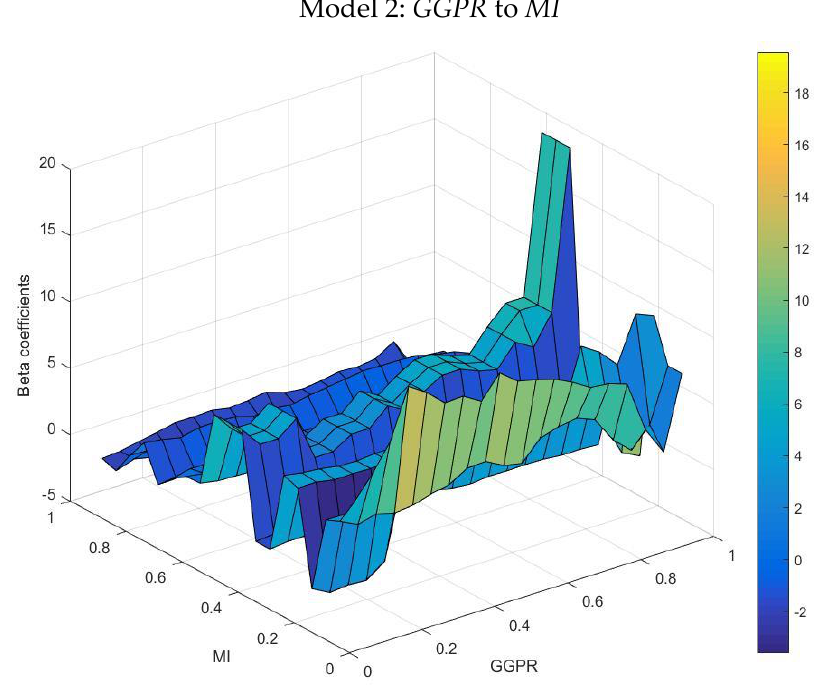
Figure 7. Global geopolitical risk ( GGPR ) and mineral import ( MI ). Notes: The z -axis exhibits the slope coefficients against the quantiles of MI ( θ ) on the y -axis and the quantiles of GGPR ( τ ) on the x -axis. The yellow and green colors represent the strongly positive slope coefficients, while the light blue colors display the moderately positive slope coefficients. Besides, the dark blue color reveals the trivially negative slope coefficients.